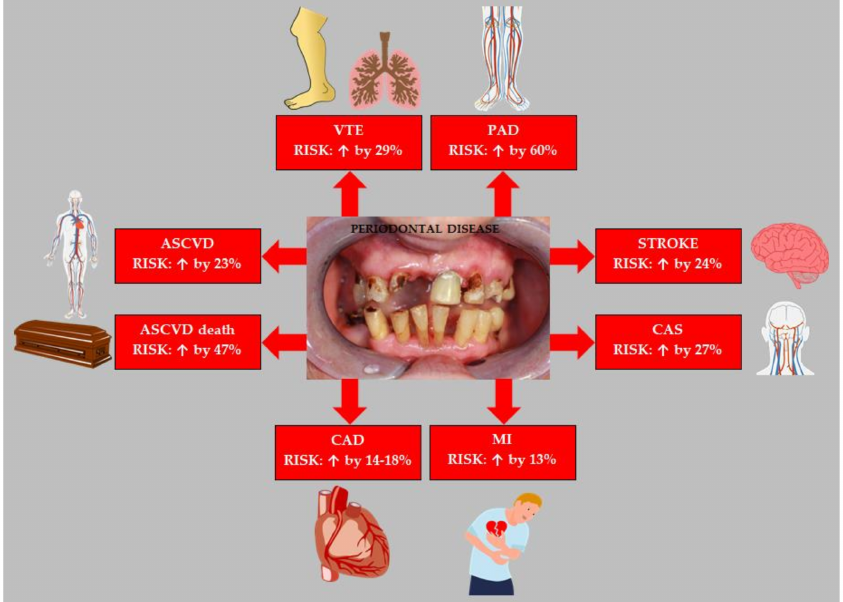
Figure 3. Effect of periodontal disease on the risk of atherosclerotic cardiovascular disease. Based on data from [96–98,101,102,106,111]. Abbreviations: ASCVD (atherosclerotic cardiovascular disease); VTE (venous thromboembolism); PAD (peripheral arterial disease); CAS (carotid artery stenosis); MI (myocardial infarction); CAD (coronary artery